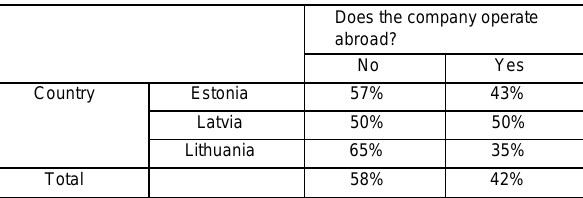
Table 8. The Studied Baltic Companies